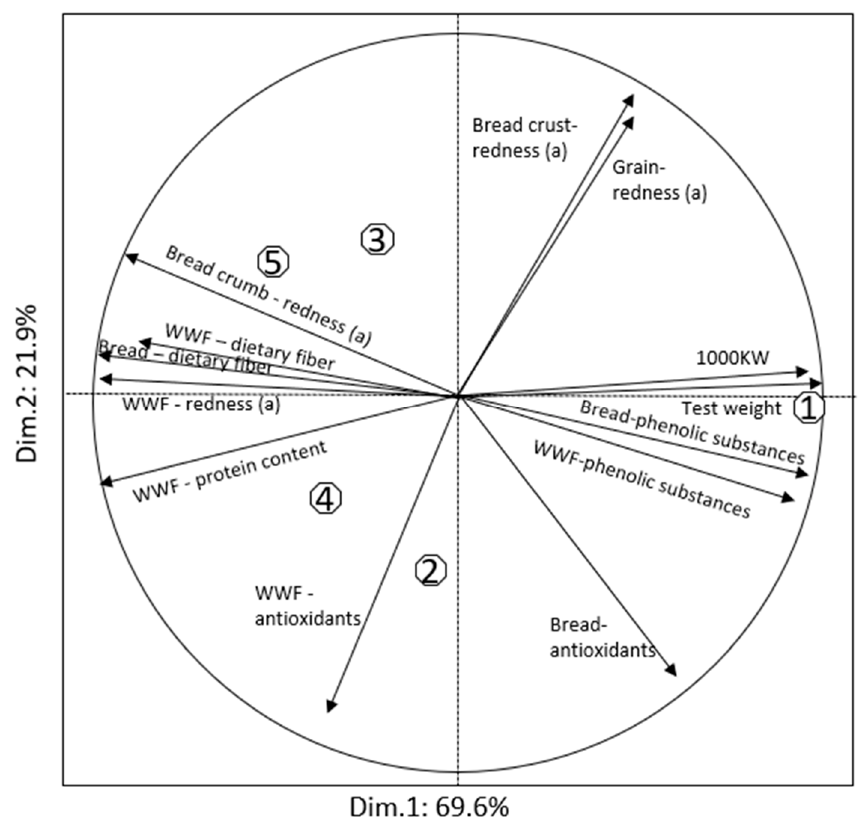
Figure 3. Biplot analysis of grain quality traits, in Konya, Turkey, 2018. (1) Seri, (2) S29-Purple(PF), (3) S29-Red(PF), (4) S29-Purple(P), and (5) S29-Red(P). WWF, whole wheat flour.